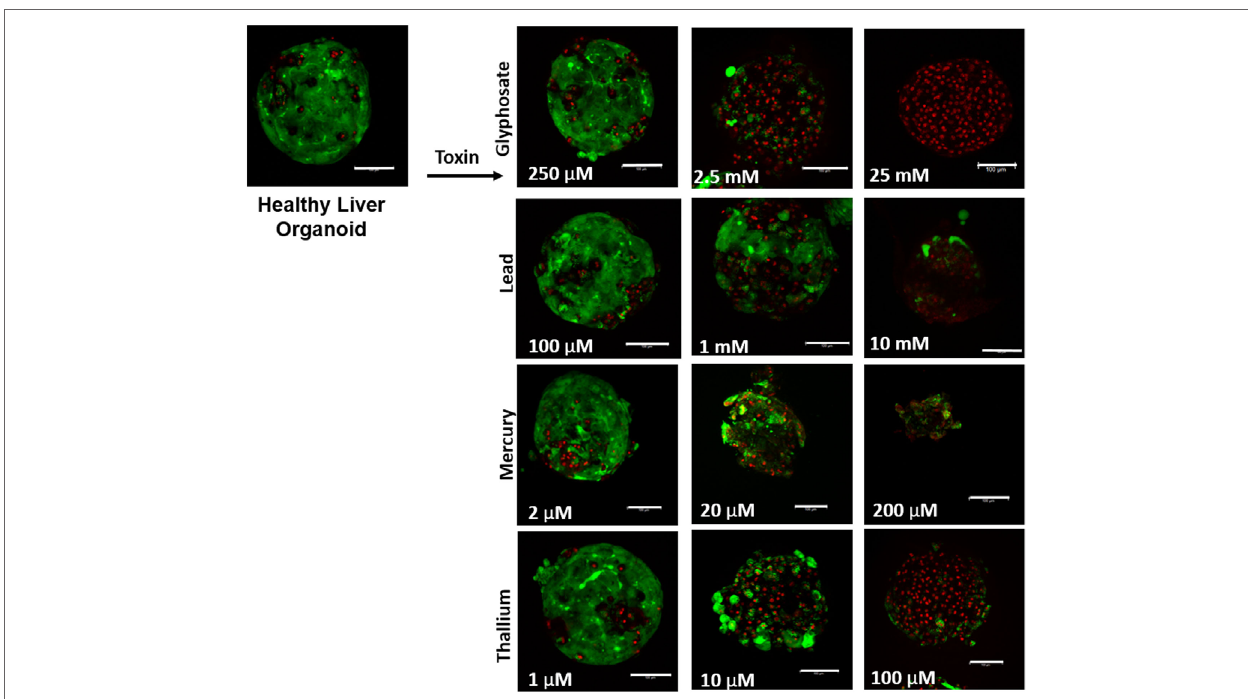
FigUre 1 | Visual assessment of environmental toxin effects on liver organoids by live/dead assay. The effects of glyphosate, lead, mercury, and thallium on liver organoids using ethidium homodimer dead (red) and calcein AM live (green) staining. Scale bars are equal to 100 µm.